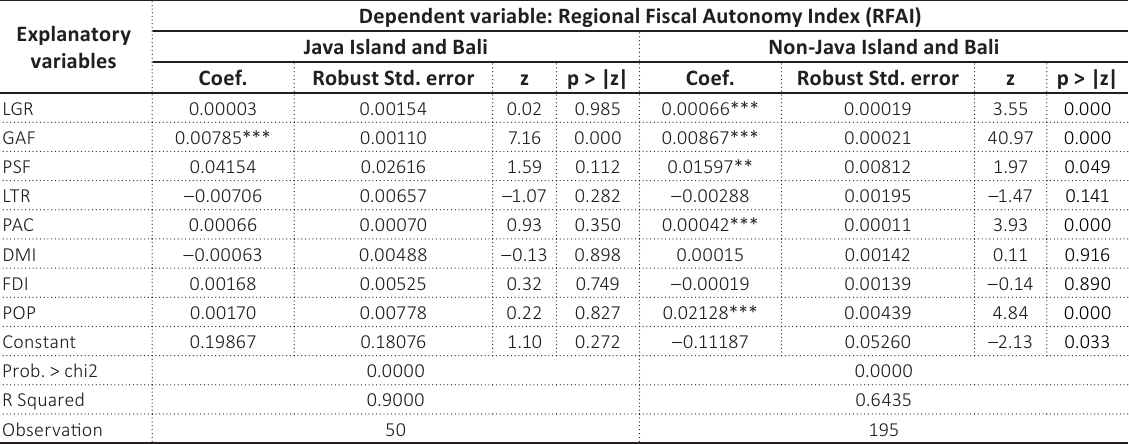
Table 6. Impact of the structure of local government budgets on local fiscal autonomy (Java Island and Bali versus Non-Java Island and Bali) Explanatory